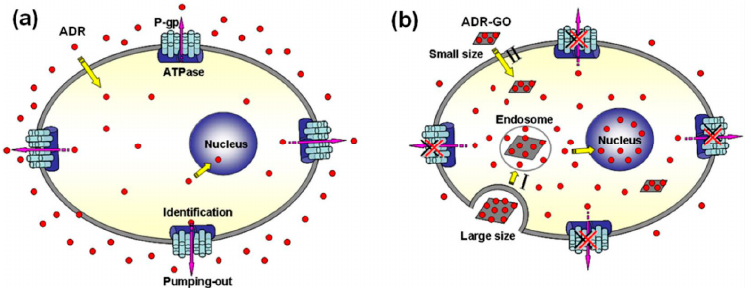
Figure 1. Schematic diagram of ( a ) the adriamycin (ADR) resistance mechanism of surface P-gp in MCF-7/ADR cells and ( b ) the mechanism of Adriamycin graphene oxide (ADR-GO) reversing the ADR resistance [14].